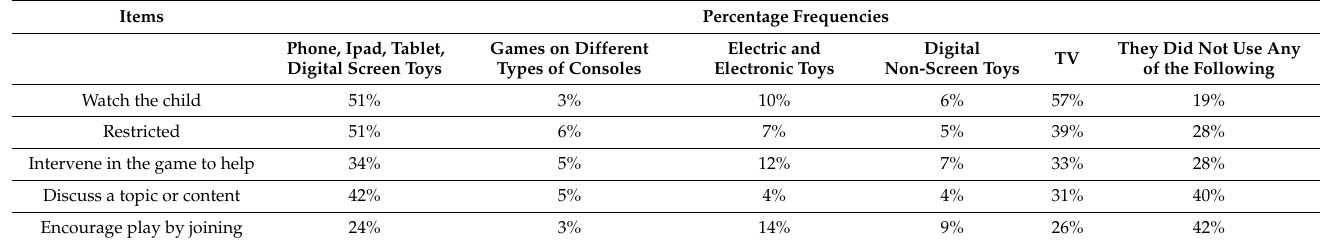
Table 6. Parental mediation in their child’s play—analogue vs.